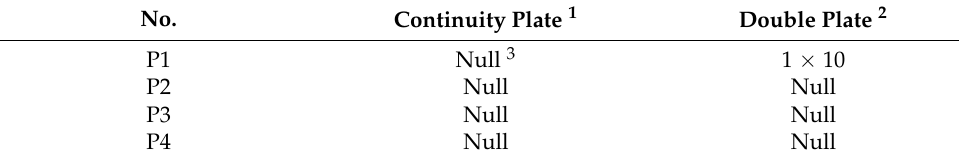
Table 7. Final web panel details (size in